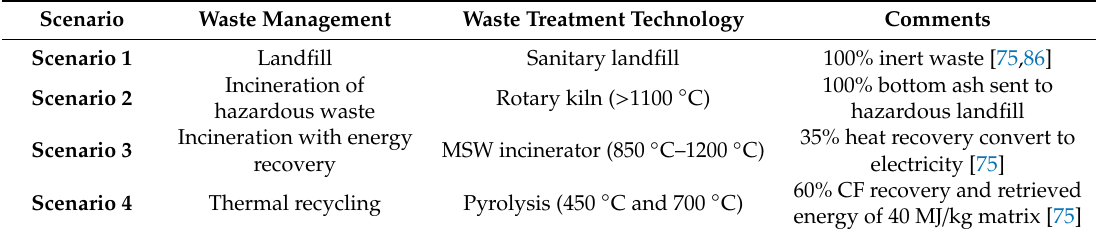
Figure 3. End-of-life (EOL) treatment scenarios for the composite products (values given per kg product waste). Table 3. The four end-of-life (EoL) scenarios and the respective waste treatment technology applied.